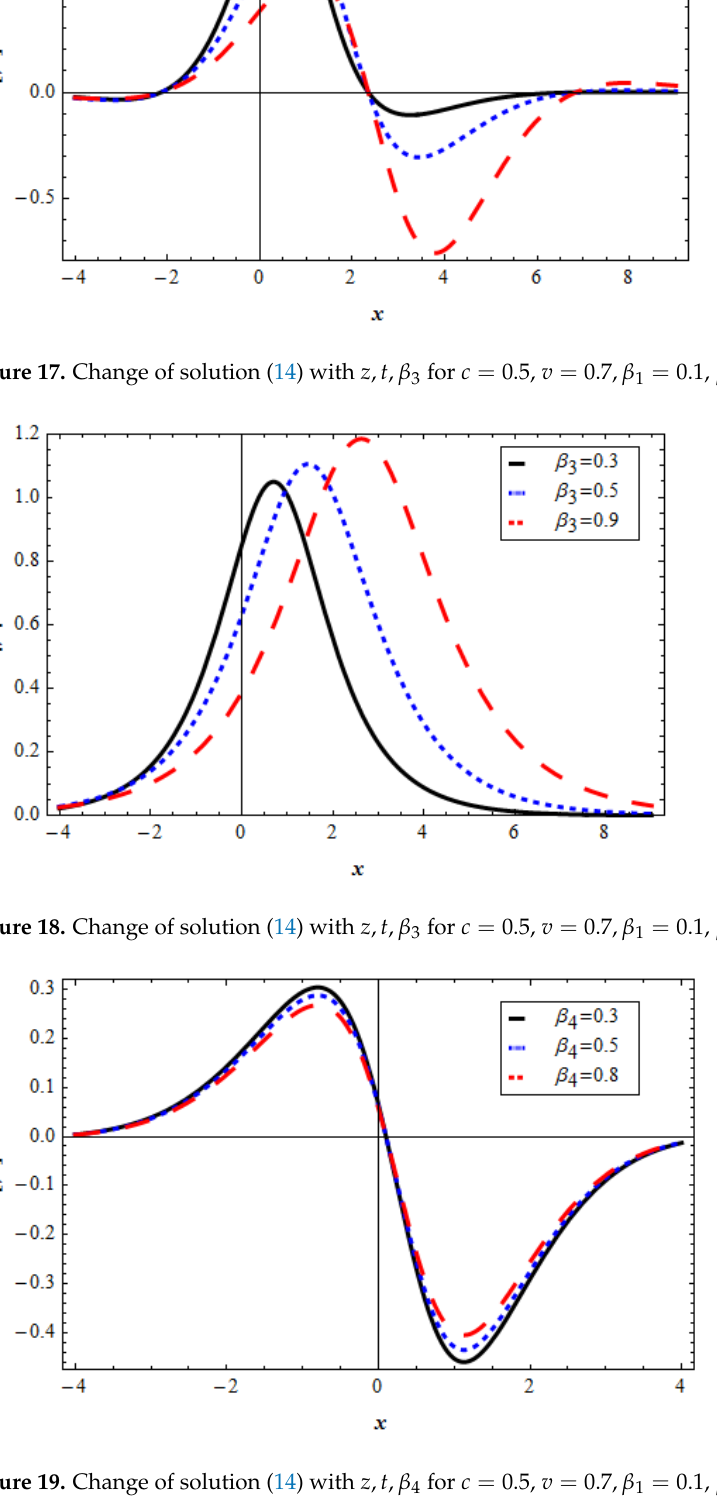
Figure 19. Change of solution (14) with z , t , β 4 for c = 0.5, v = 0.7, β 1 = 0.1, β 2 = 1, β 3 =